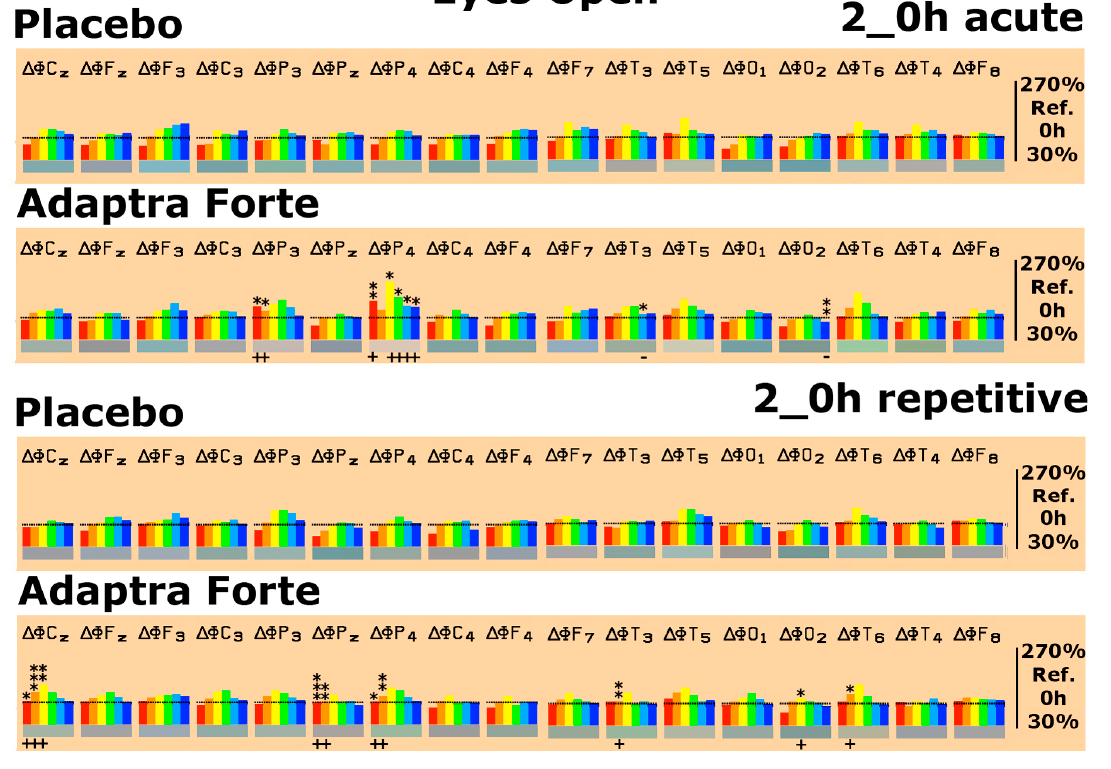
Figure 2. Spectral power differences under the eyes open recording condition on the first experimental day (acute) and on the last experimental day (repetitive) with administration of placebo or Adaptra ® Forte in all brain regions as represented by the electrode positions. C = central, p = parietal, O = occipital, F = frontal, T = temporal. Even numbers indicate location in the right hemisphere while odd numbers indicate the left hemisphere. Frequencies: red = δ , orange = θ , yellow = α 1, green = α 2, turquoise = β 1, and blue = β 2. The spectral power (between 30% and 270% on the ordinate of the bar graph) was averaged over 6 min and plotted against the pre-drug value (values at 0 min set as 100%), thus reflecting the effect of placebo or Adaptra ® Forte. * p < 0.12; ** p < 0.05; *** = p < 0.01 (non-parametric sign test) between placebo and Adaptra ® Forte. The direction of change is marked by + or − underneath the relevant bar.